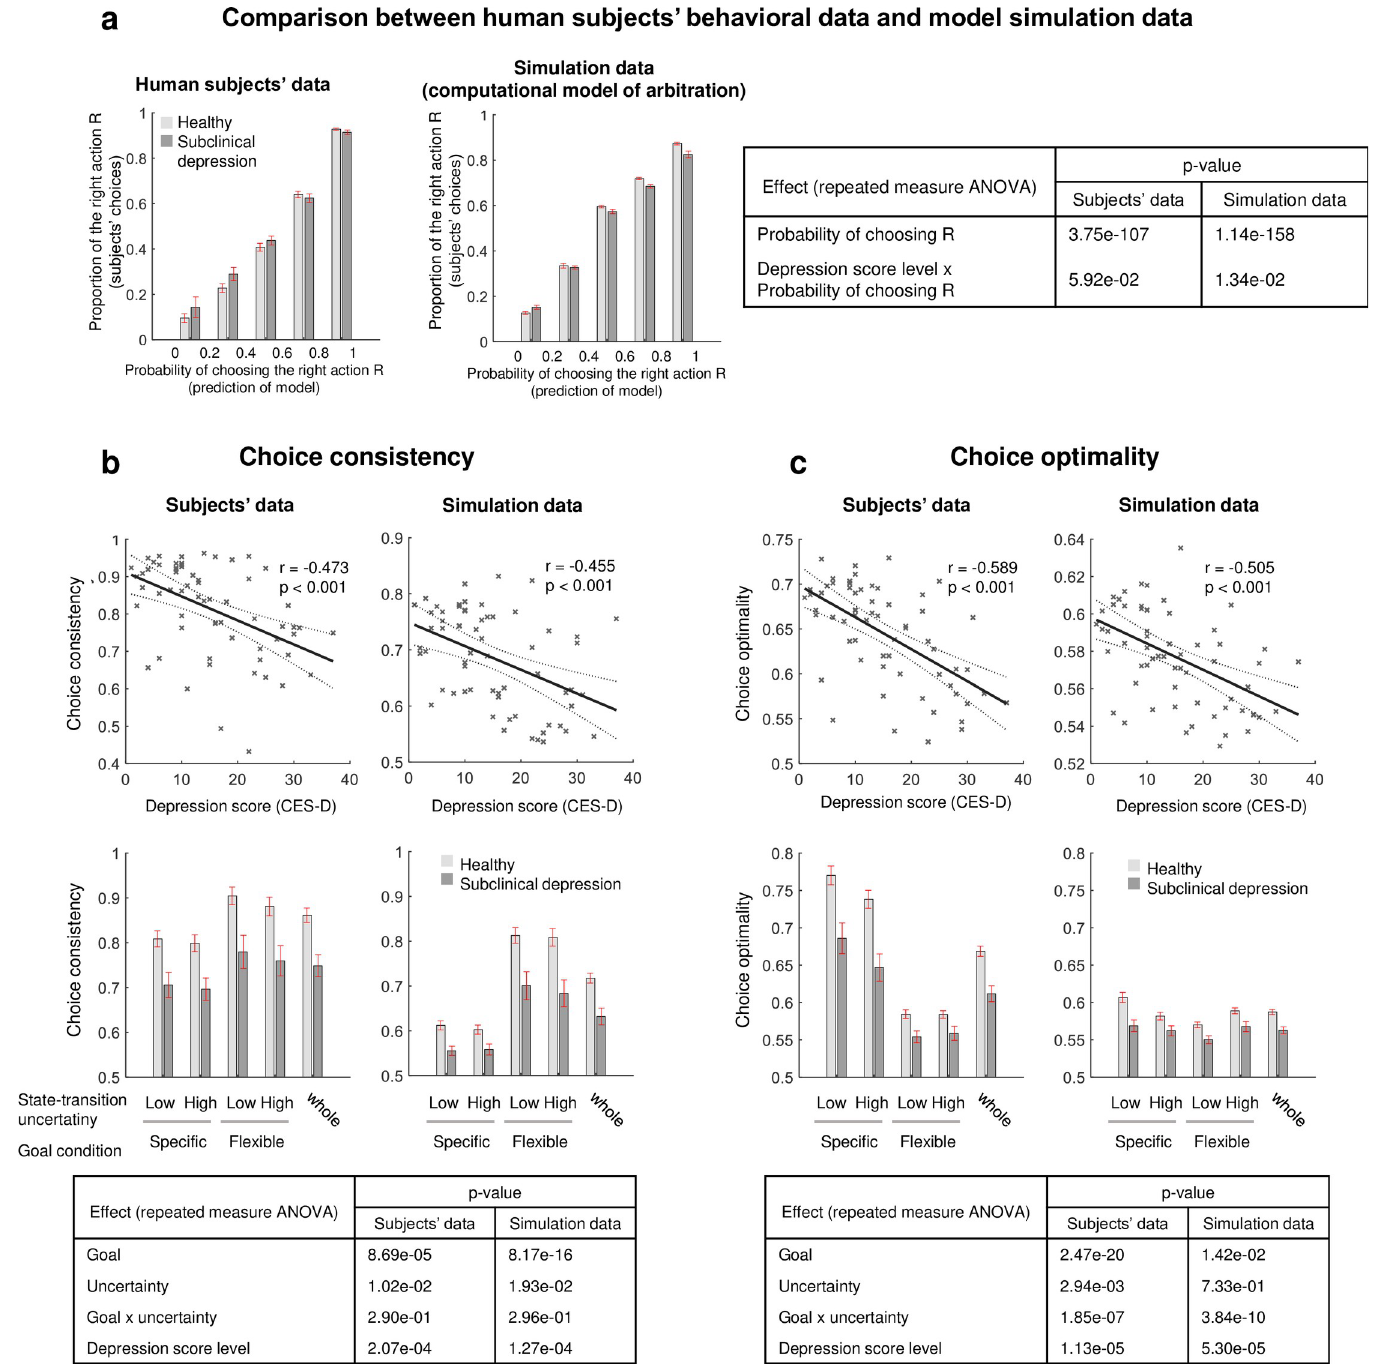
Fig 4. Computational model of arbitration explains subjects’ behavioral patterns associated with depression symptom. (a) Proportion of actual choice of the agent [26,30],based on human subjects’ data (left) and averaged data of 100 simulations of the computational model fitted on each subject (middle). The healthy and subclinical depression group were defined by the standard cutoff criteria of the CES-D score 16 [31,32].It is the proportion of the right action (R) as a function of choice probability, computed based on the value difference between the two choices (R and L). The key effects found in the subjects’ data were replicated in the simulation data. (b) Choice consistency, a behavioral measure associated with model-free learning. It is defined as the proportion of making the same choice as in previous trials. The significant correlation between choice consistency and the depression symptom (CES-D) in subjects’ data (left scatter plot) is replicated in the model simulation data (right scatter plot). The results were replicated in terms of the effect of the key task variables (goal and uncertainty) on choice consistency (error bar plots and the statistical test results; both the main and interaction effects were replicated). (c) Choice optimality, a measure of the extent to which a subject’s choice reflects an optimal policy. The significant correlation between choice optimality and the depression symptom (CES-D) in subjects’ data (left scatter plot) is replicated in the model simulation data (right scatter plot). The results were also replicated in terms of the effect of the key task variables on choice optimality (except for the uncertainty effect). https://doi.org/10.1371/journal.pcbi.1009003.g004 PLOS Computational Biology | https://doi.org/10.1371/journal.pcbi.1009003 May 14,